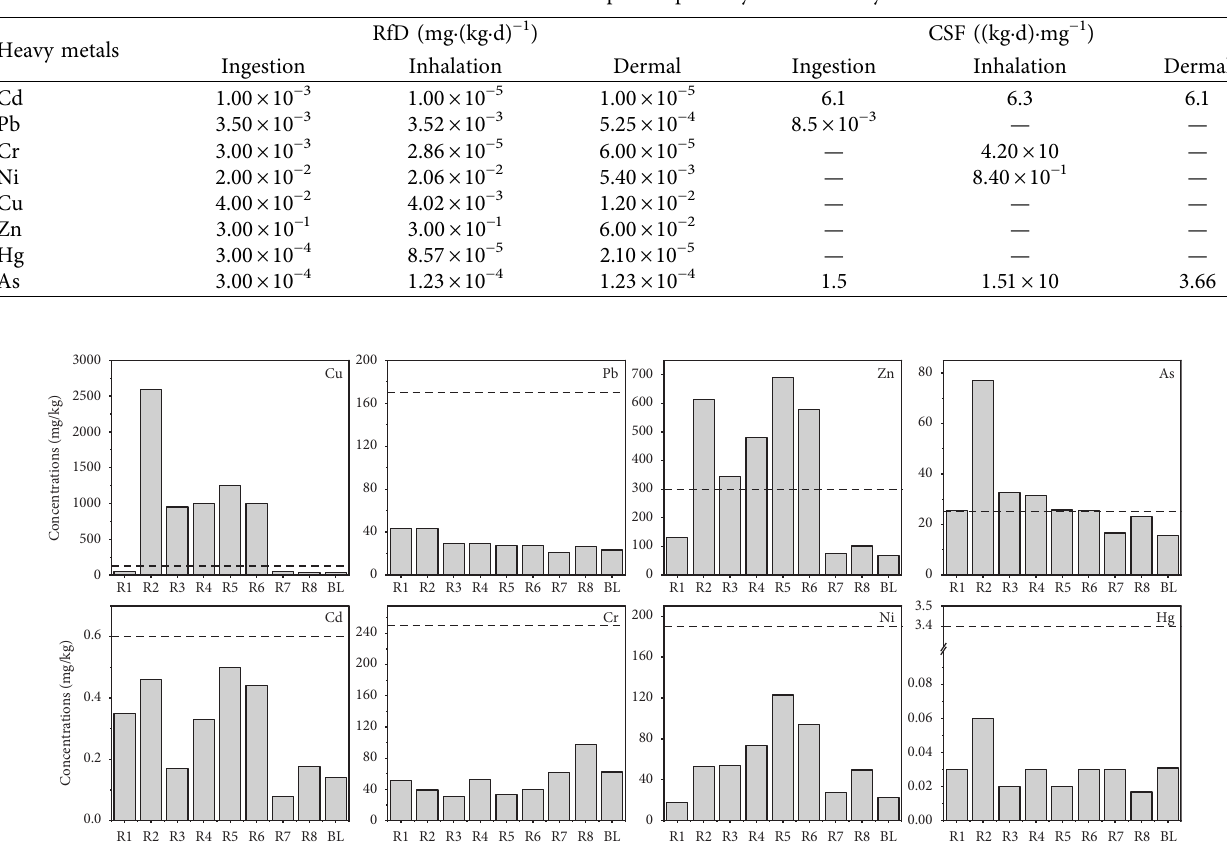
Table 4: RfD and SF of different exposure pathways of soil heavy metals.